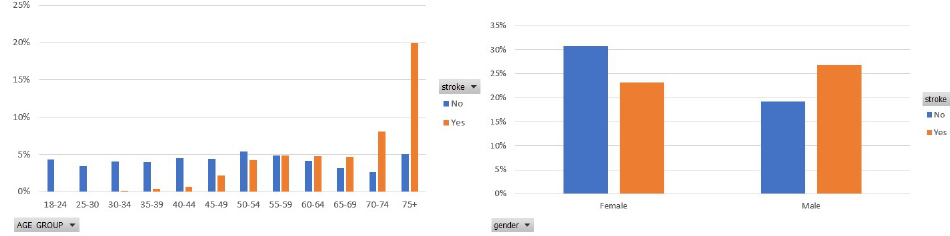
Figure 1. Participants distribution per age group and gender type in the balanced